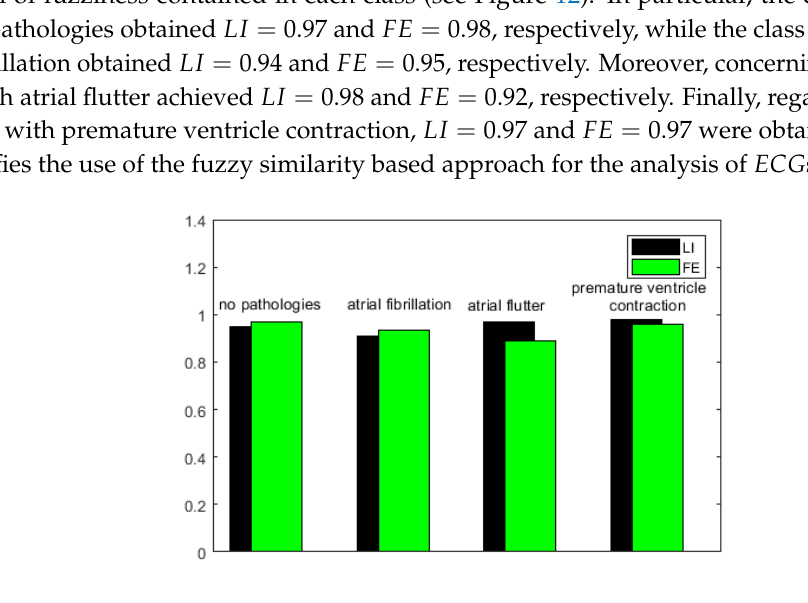
Figure 12. Evaluation of linear index (LI) and fuzzy entropy (FE) for each category of ECG